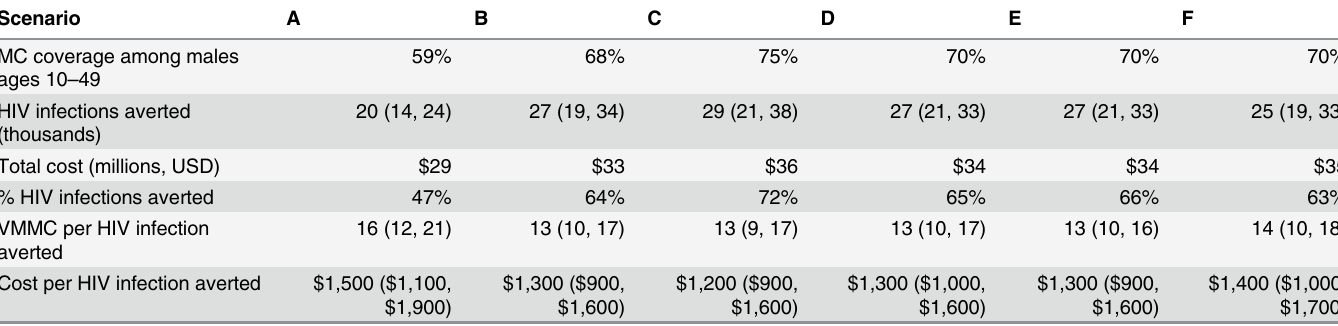
Table 2. Impact, Cost, and Cost-effectiveness of VMMC Scale-up Scenarios, 2014 – 2028. Scenario